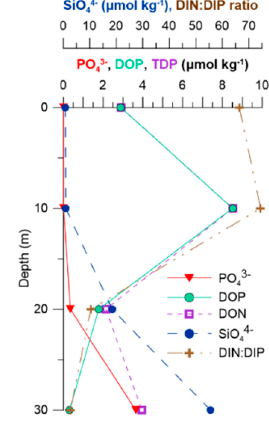
Figure 4. Vertical distribution of nutrients. ( a ) NO 3 − , NO 2 − , NH 4+ , dissolved organic nitrogen (DON) and total dissolved nitrogen (TDN) in µ mol kg − 1 and ( b ) PO 43 − , dissolved organic phosphorus (DOP), total dissolved phosphorus (TDP) and SiO 44 − in µ mol kg − 1 and DIN:DIP ratio during field sampling (September 2014). Table 1. Seawater carbonate system parameters, as calculated by the ‘CO2SYS’ package for field (absolute values) and the OA and C experimental microcosms (mean values, standard deviations, minimum and maximum values). Calculation of A T , DIC, HCO 3 − , CO 32 − and CO 2 in µ mol kg − 1 , and of p CO 2 in µ atm was based on A T , pH T , salinity and nutrients. Field / Condition